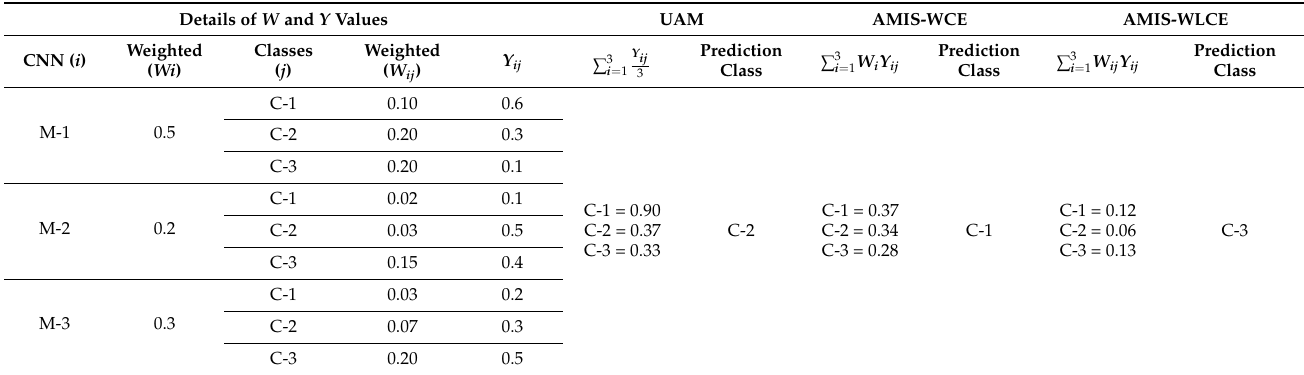
Table 15. Examples of using different fusion strategies to find the classification result of WP 1.